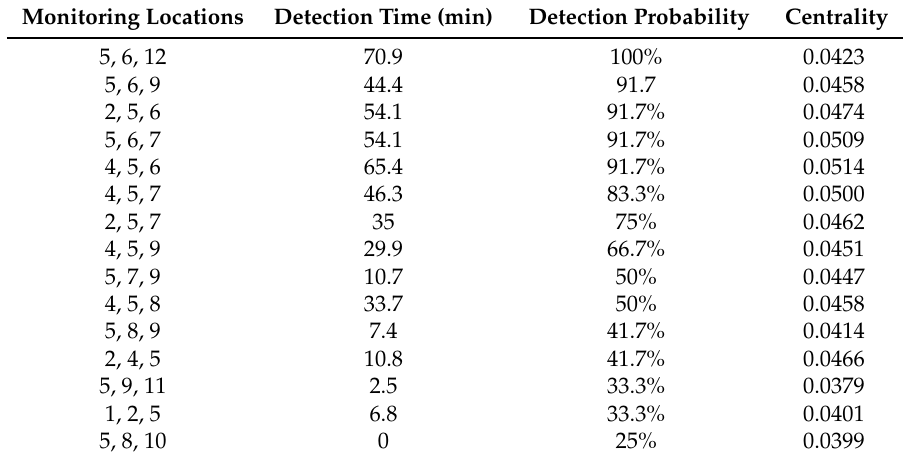
Table 10. Pollution detection time,probability and centrality in Pareto frontier with reserved monitoring location